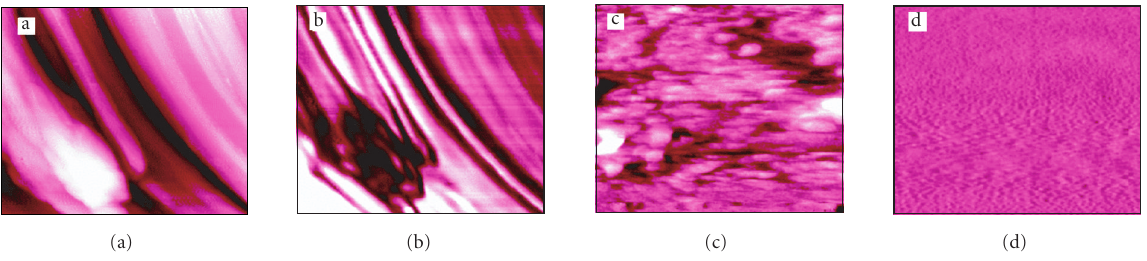
Figure 32: Simultaneous shear-force AFM (a), (c) (10 μ m, Z range 400nm) and apertureless SNOM (b), (d) of an abraded copper alloy: (a) and (b) before, (c) and (d) after standard electrochemical load, securing very uniform corrosion as judged by lack of SNOM contrast.